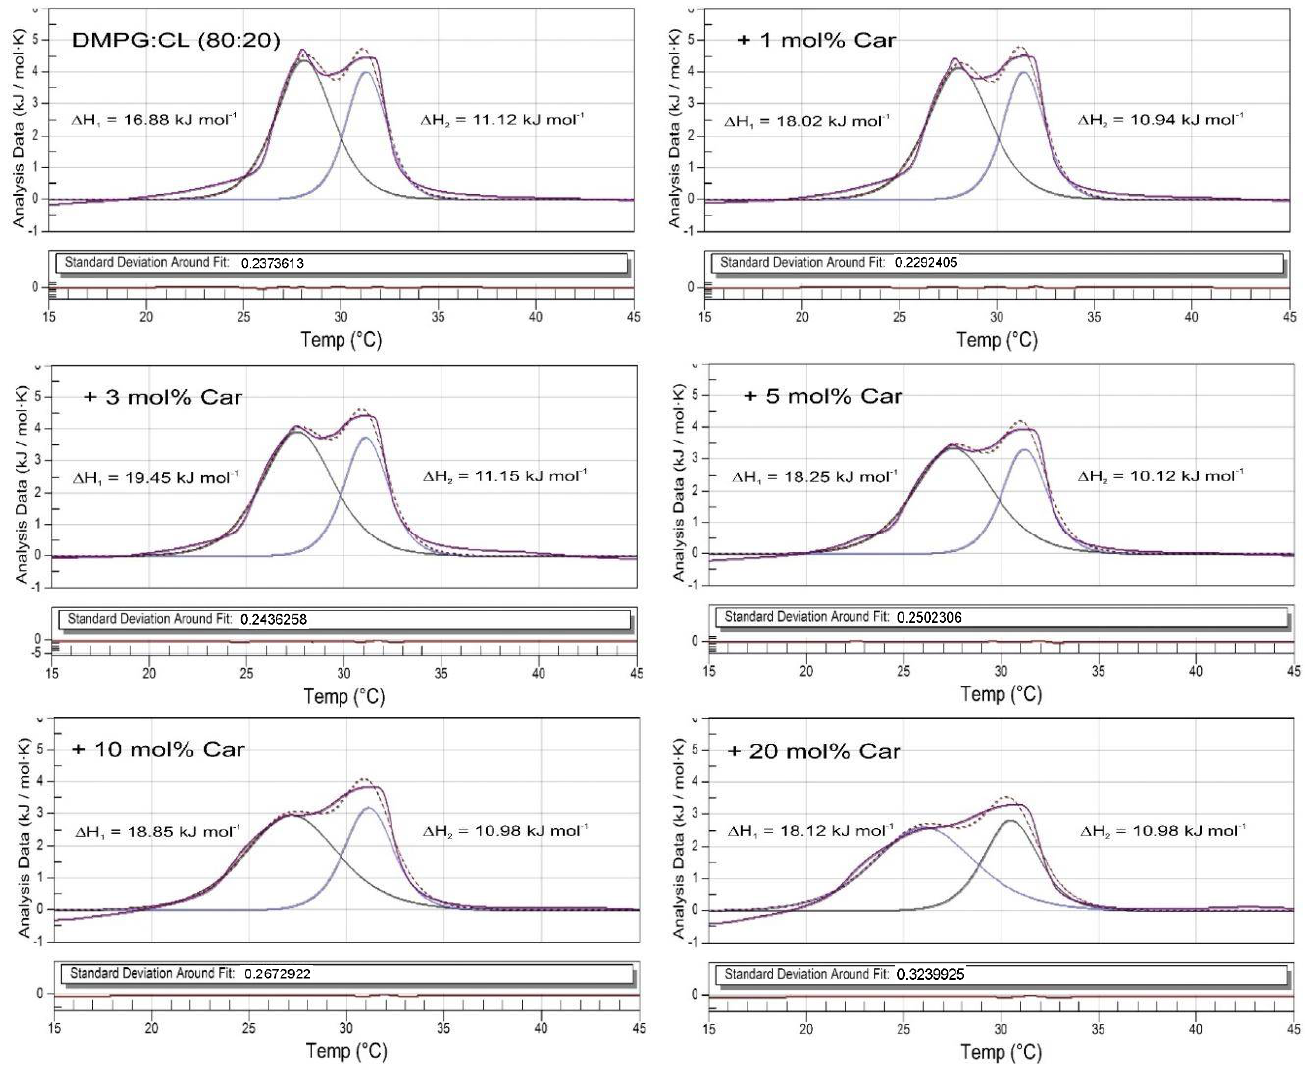
Figure 2. Deconvolution peaks of representative DSC heating curves obtained for multilamellar liposomes prepared from DMPG and CL mixture DMPG:CL (80:20).